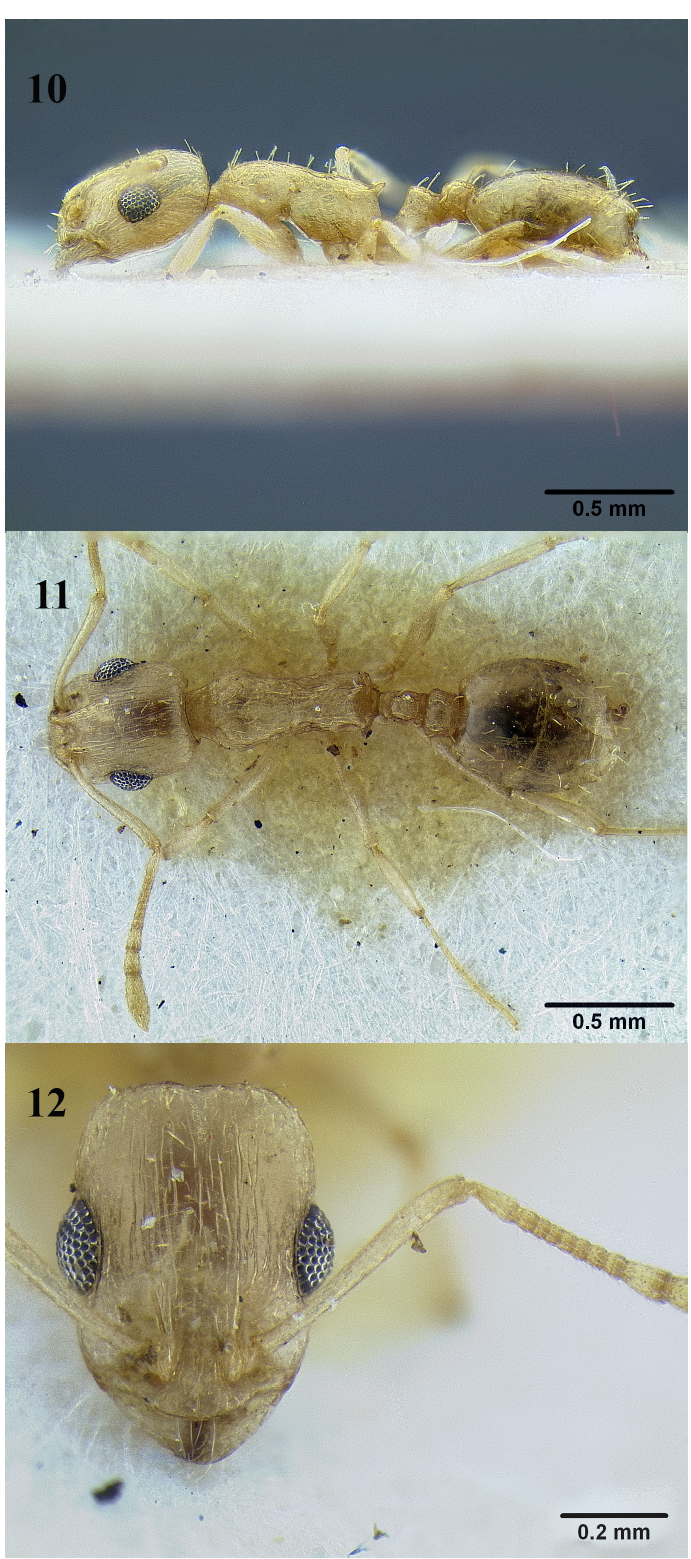
Figs 10–12 . Temnothorax megalops (Hamann & Klemm, 1967), holotype, worker (CASENT0712601). 10 . Body in profile. 11 . Body in dorsal view. 12 . Head in frontal